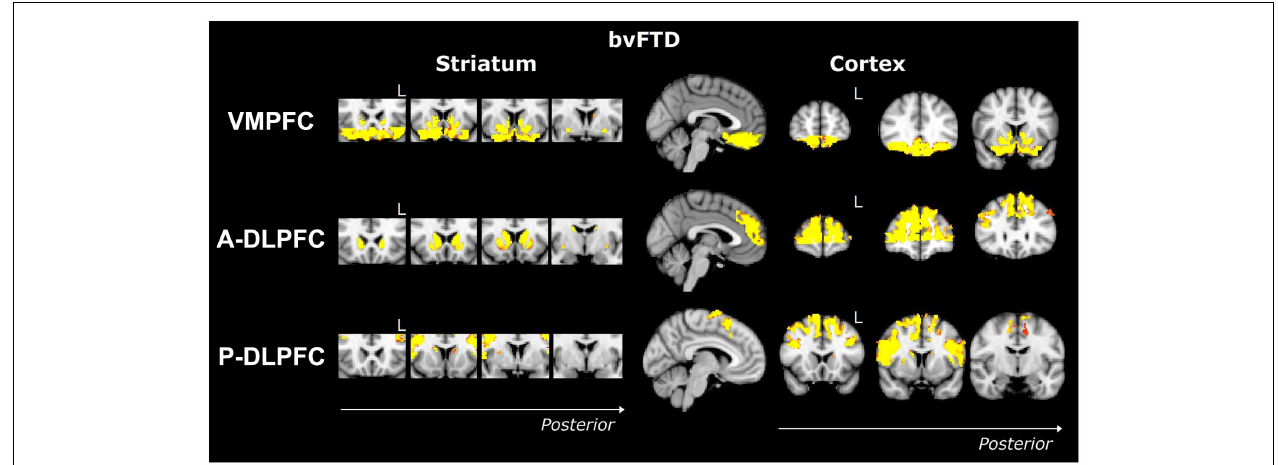
significant in the analyses for p < 0.05 corrected for multiple comparisons via family-wise error (FWE) and a voxel threshold of 20 contiguous voxels. Images follow radiological convention (left is right and right is left) and “L” indicates the left for coronal slices.